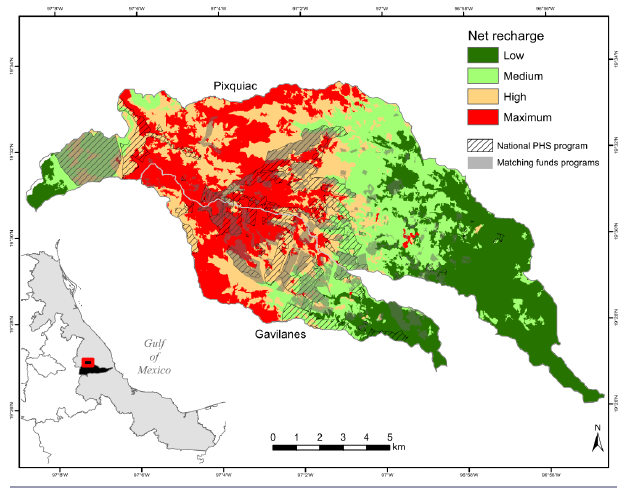
Fig. 1 . Map comparing areas of different levels of net recharge with those receiving payments for hydrologic services (PHS) from the national (diagonal line shading) and local matching programs (grey shading) during the period 2003–2011 in the Pixquiac and Gavilanes watersheds. Also shown is the location of these watersheds in the large Antigua River basin and the state of Veracruz, Mexico (lower left